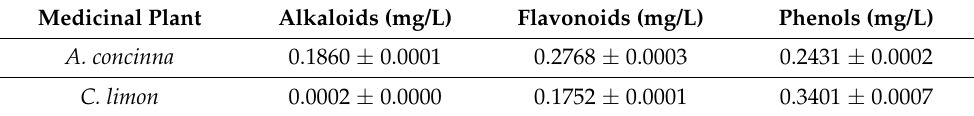
Table 2. Concentration of some phytochemicals observed from plant extracts. Medicinal Plant Alkaloids (mg/L) Flavonoids